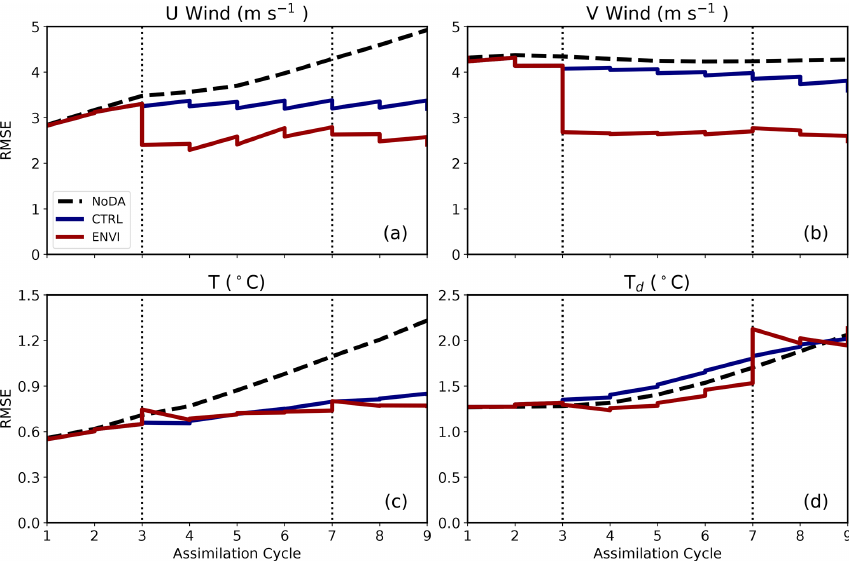
Figure 11. The domain-averaged (a) u wind, (b) v wind, (c) T , and (d) T d RMSE during the data assimilation window. Statistics consider the lowest 3km of the troposphere where forecast errors are largest. Dashed black, solid blue, and solid red lines correspond with NoDA, CTRL, and ENVI, respectively. Vertical dotted lines mark the points when conventional observations (soundings and surface) are